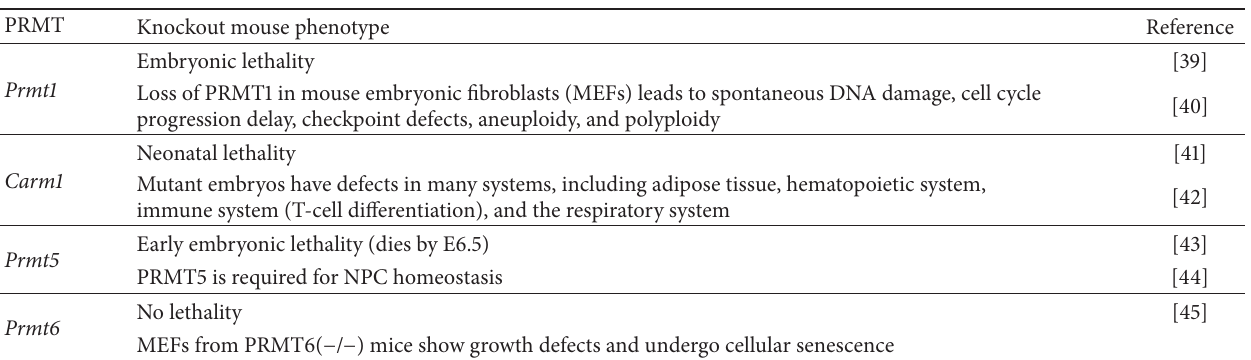
Table 4: PRMTs of knockout